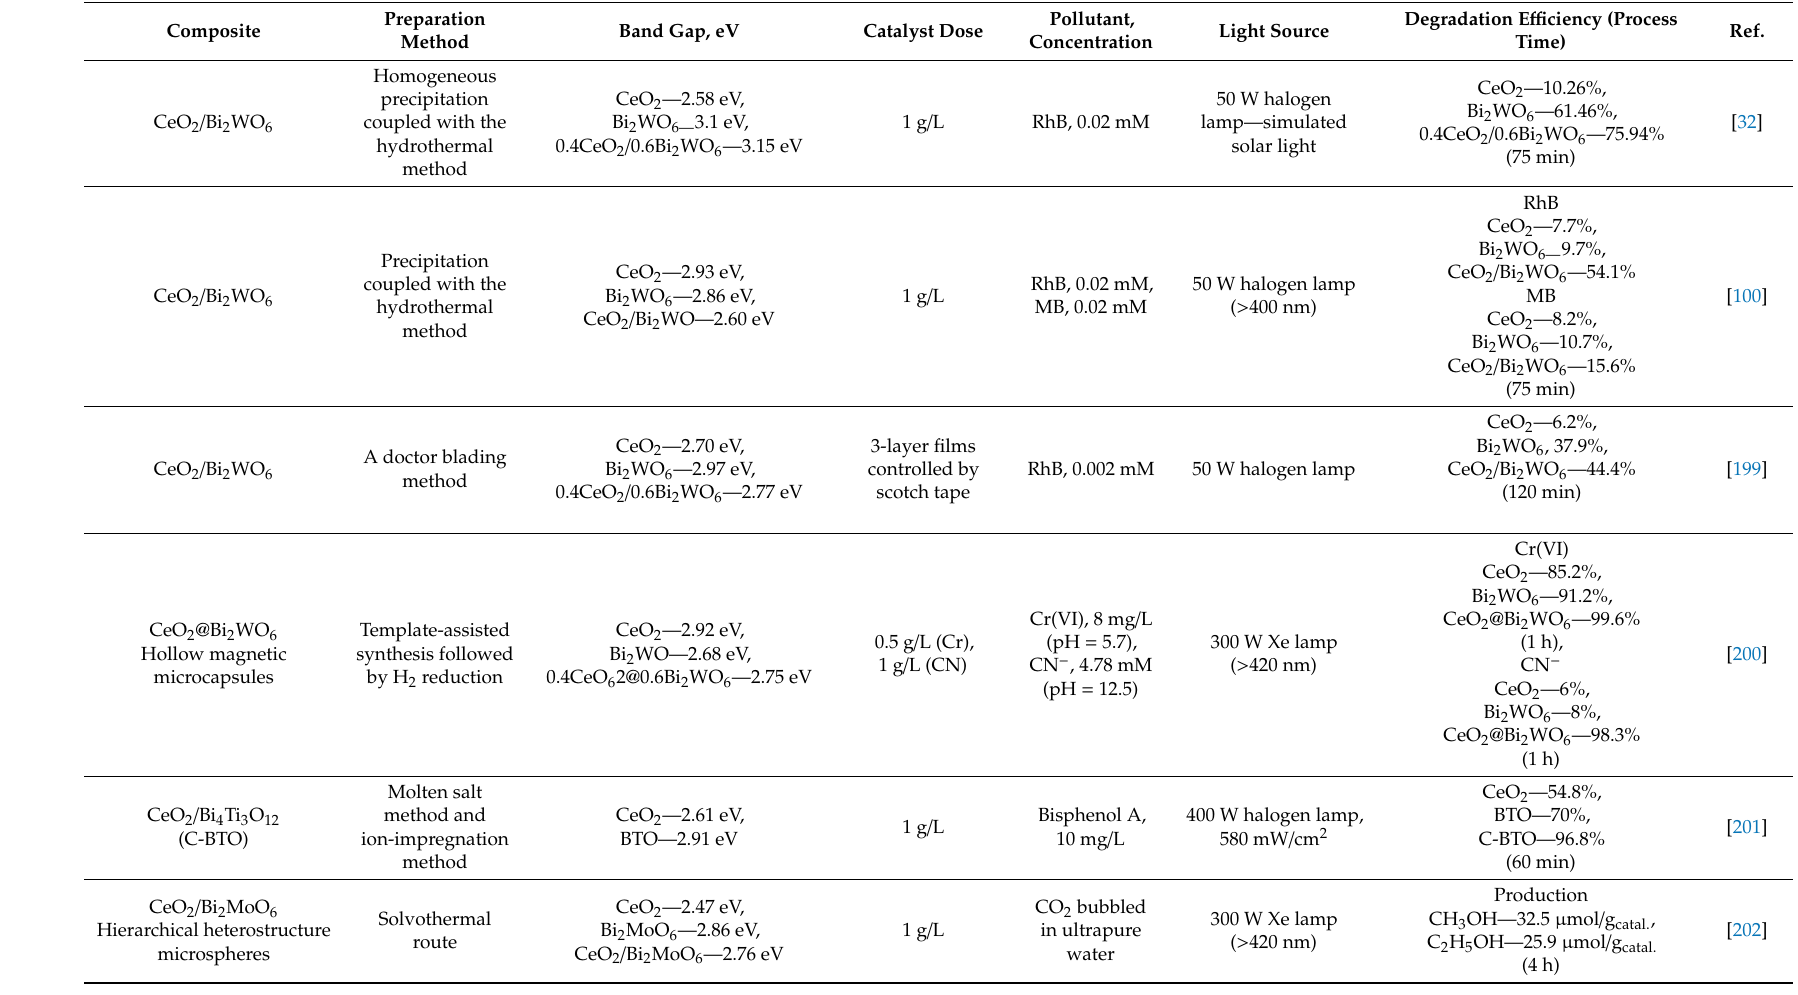
Table 5. Photocatalytic degradation of various pollutants with the application of CeO 2 composites with other